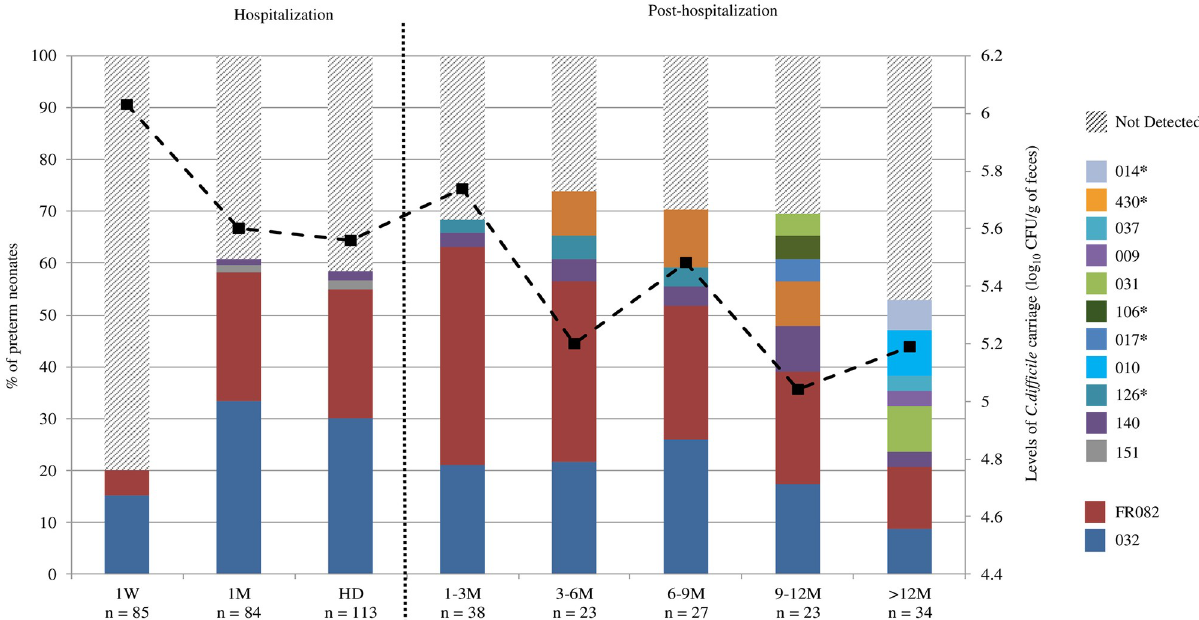
Fig 1. C . difficile colonization and PCR-ribotypes distribution during the hospitalization and post-hospitalization periods. The bars represent the percentage of the preterm neonates and the black dashed line represents the mean levels of C . difficile carriage. PCR-ribotypes references were either the standard nomenclature from the European collection (i.e. 032) when available or designated by the French National Reference Laboratory specific nomenclature (i.e. FR082). The fecal samples included for analysis during hospitalization were gathered as follows: 1 week (1W) ( � 8 days (d)) (n = 85); 1M, (20 d-40 d) (n = 84); hospital discharge (HD) (4 d-149 d) (n = 113). Since the postnatal age of the PN at HD was depending on factors such birth gestational age and health status, of the 113 HD samples, 6 and 42 corresponded respectively to the 1W and 1M sampling time points. For the post- hospitalization period, samples analyzed were distributed as follows: 1–3 M (n = 38); 3–6 M (n = 23); 6–9 M (n = 27); 9–12 M (n = 23); > 12 M (maximum 487 d) (n = 34). Not detected: threshold < 3.3 log 10 CFU/g. � , toxigenic strains.